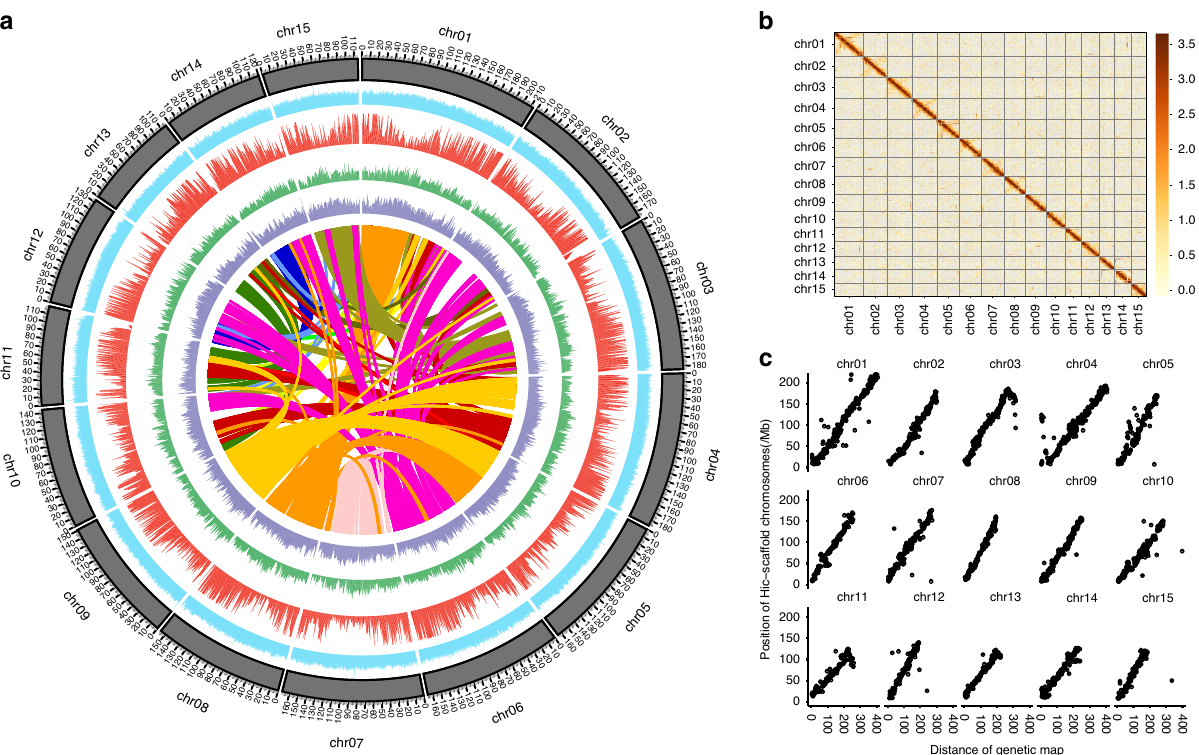
Fig. 1 Characterization and quality of the LJ43 genome. a The landscape of the LJ43 genome. From inside to outside: LJ43 gene collinearity; long terminal repeat density (purple); single-nucleotide polymorphism density (green); gene density (red); GC content (blue). The chromosome units of all aforementioned features are 1 Mbp. b Genome-wide all-by-all Hi – C interaction. The resolution is 0.5 Mbp. c The collinearity of the genetic map and assembled genome. Source data underlying Fig. 1a and c are provided as a Source Data fi le.